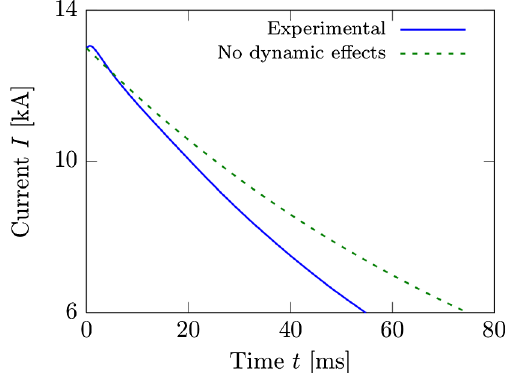
FIG. 2. Comparison between the experimental current decay (solid blue curve) and a pure exponential (dashed green curve).